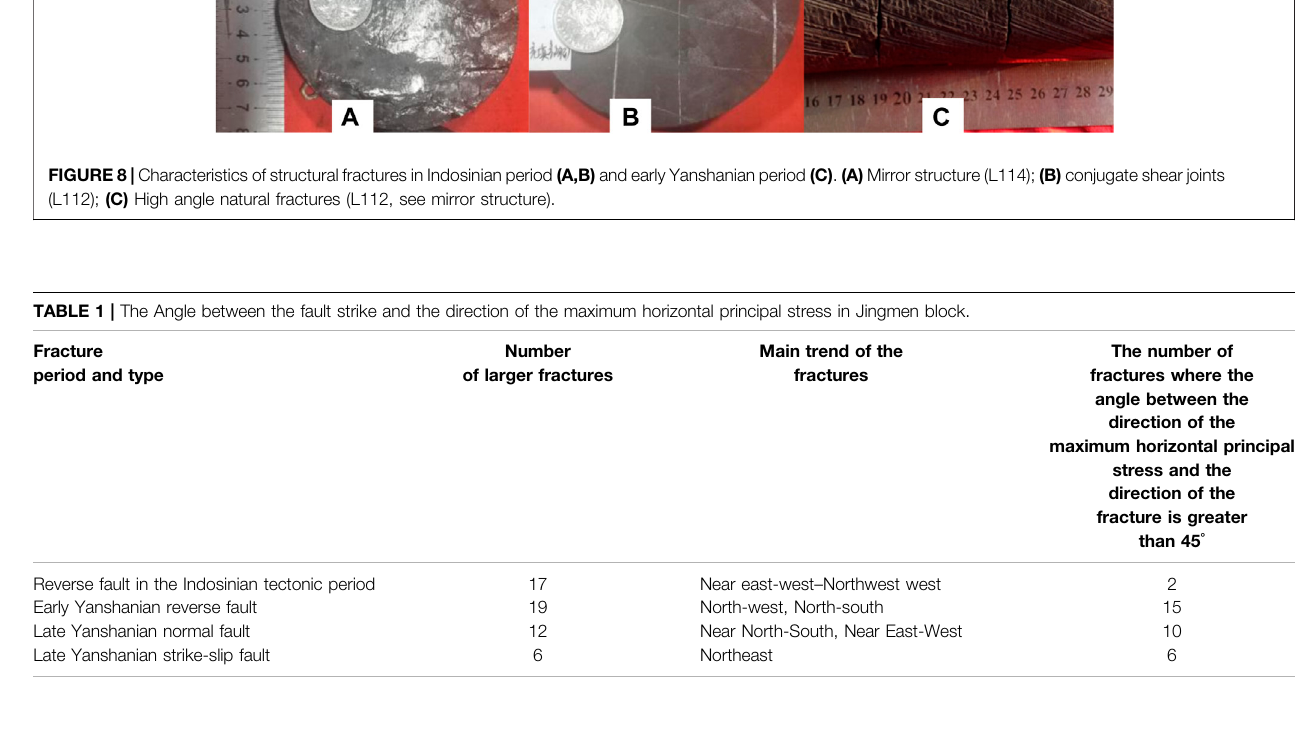
TABLE 2 | Summary of average index parameters of organic shale reservoirs in shale gas wells of the Jingmen